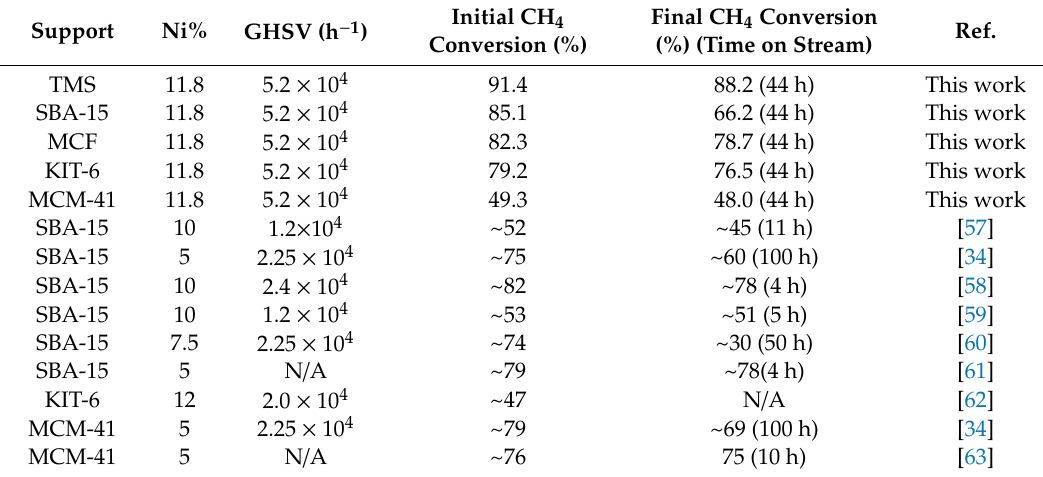
Table 1. Initial and final CH 4 conversion (%) of DRM at ambient pressure and 700 °C over Ni supported on different ordered mesoporous silicates those were prepared impregnation method.